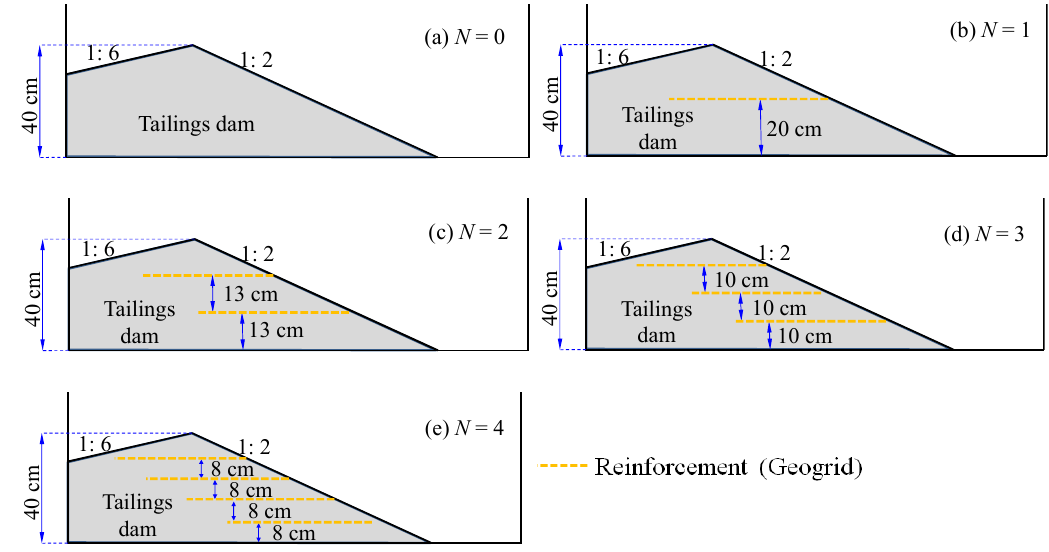
Figure 3. The schematic diagram of geo-grid laying. ( a ) N = 0; ( b ) N = 1; ( c ) N = 2; ( d ) N = 3; ( e ) N = 4.